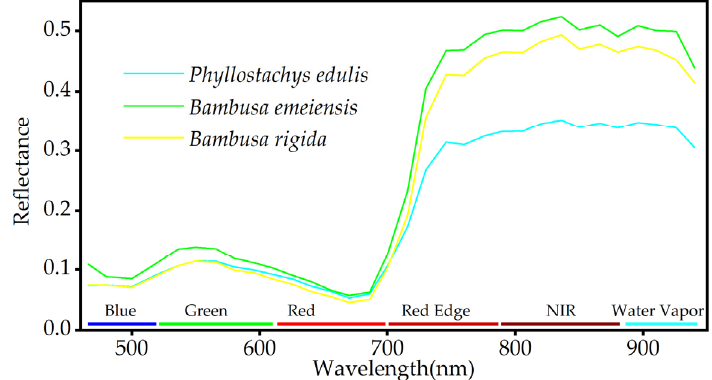
Figure 4. Average spectral signature curves of three bamboo species.